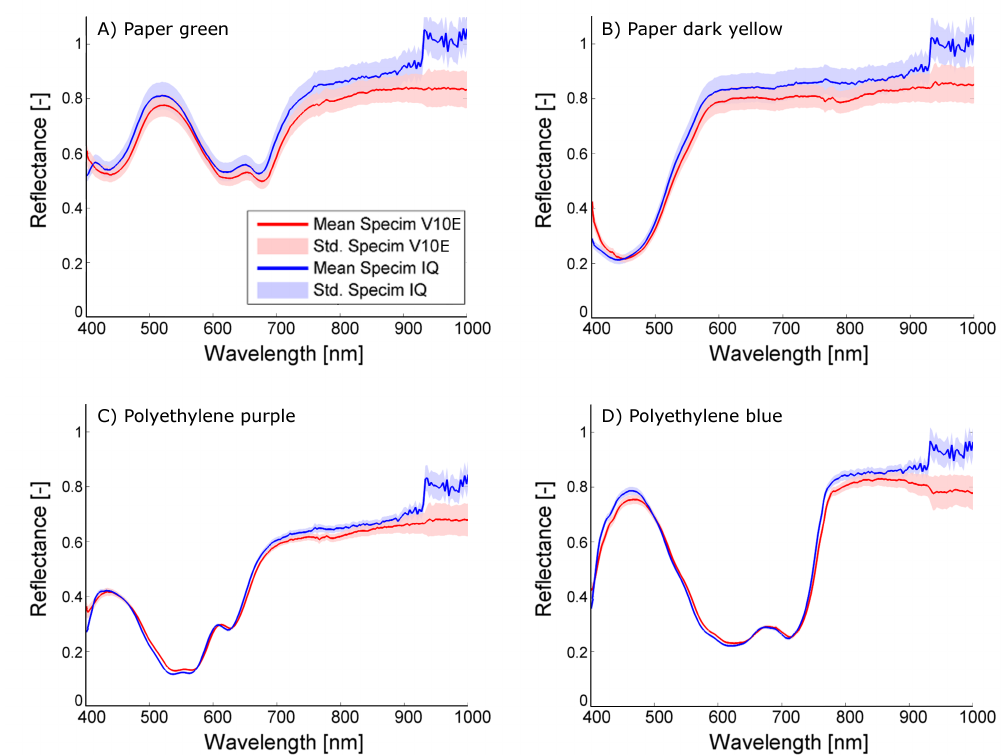
Figure 4. Comparison of spectral reflectance spectra from the outdoor experiment ( A – D ): paper green, paper dark yellow, Polyethylene purple, Polyethylene blue. Beside the increased reflectance observed by the Specim IQ in the NIR, all spectra reveal a high level of